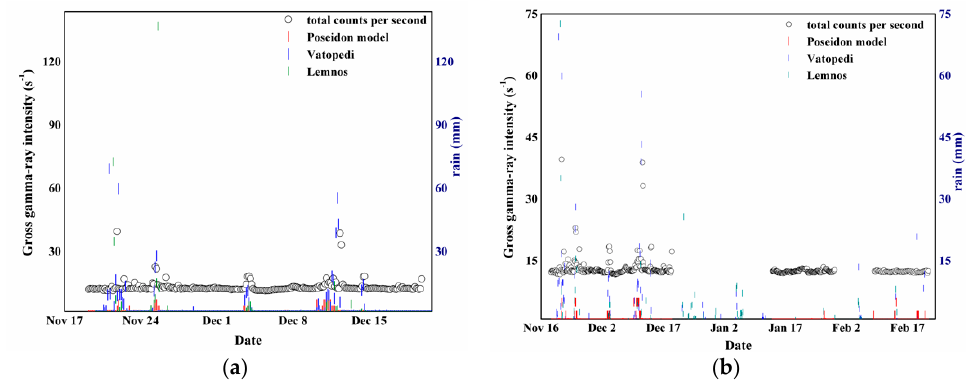
Figure 4. The counting rate (as given from the KATERINA II system) and the rain intensity from Poseidon model and Lemnos and Vatopedi stations for two periods: 20/11/2019–22/02/2020 ( b ) and from 20/11/2019–20/12/2019 ( a ).